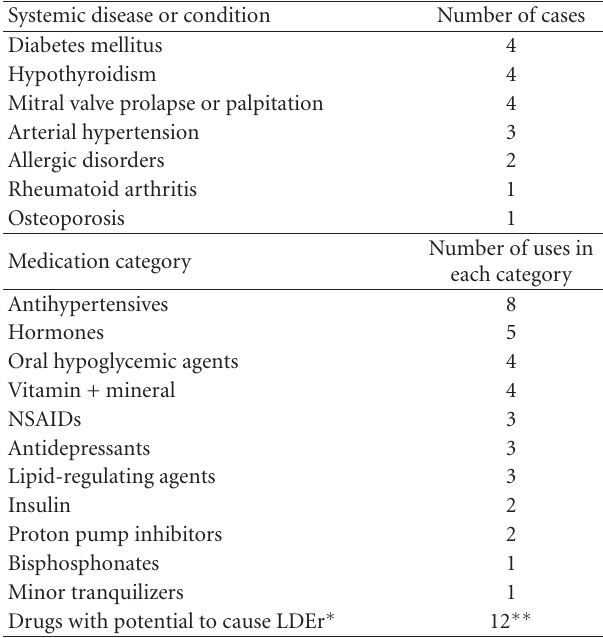
Table 2: Diseases and systemic medications used on a regular basis among 36 OLP women at the initial clinical examination.